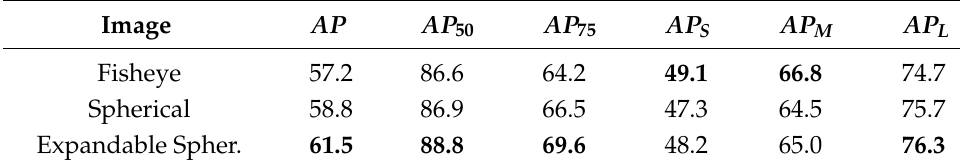
Table 2. Accuracy of different projections of SCat model on the